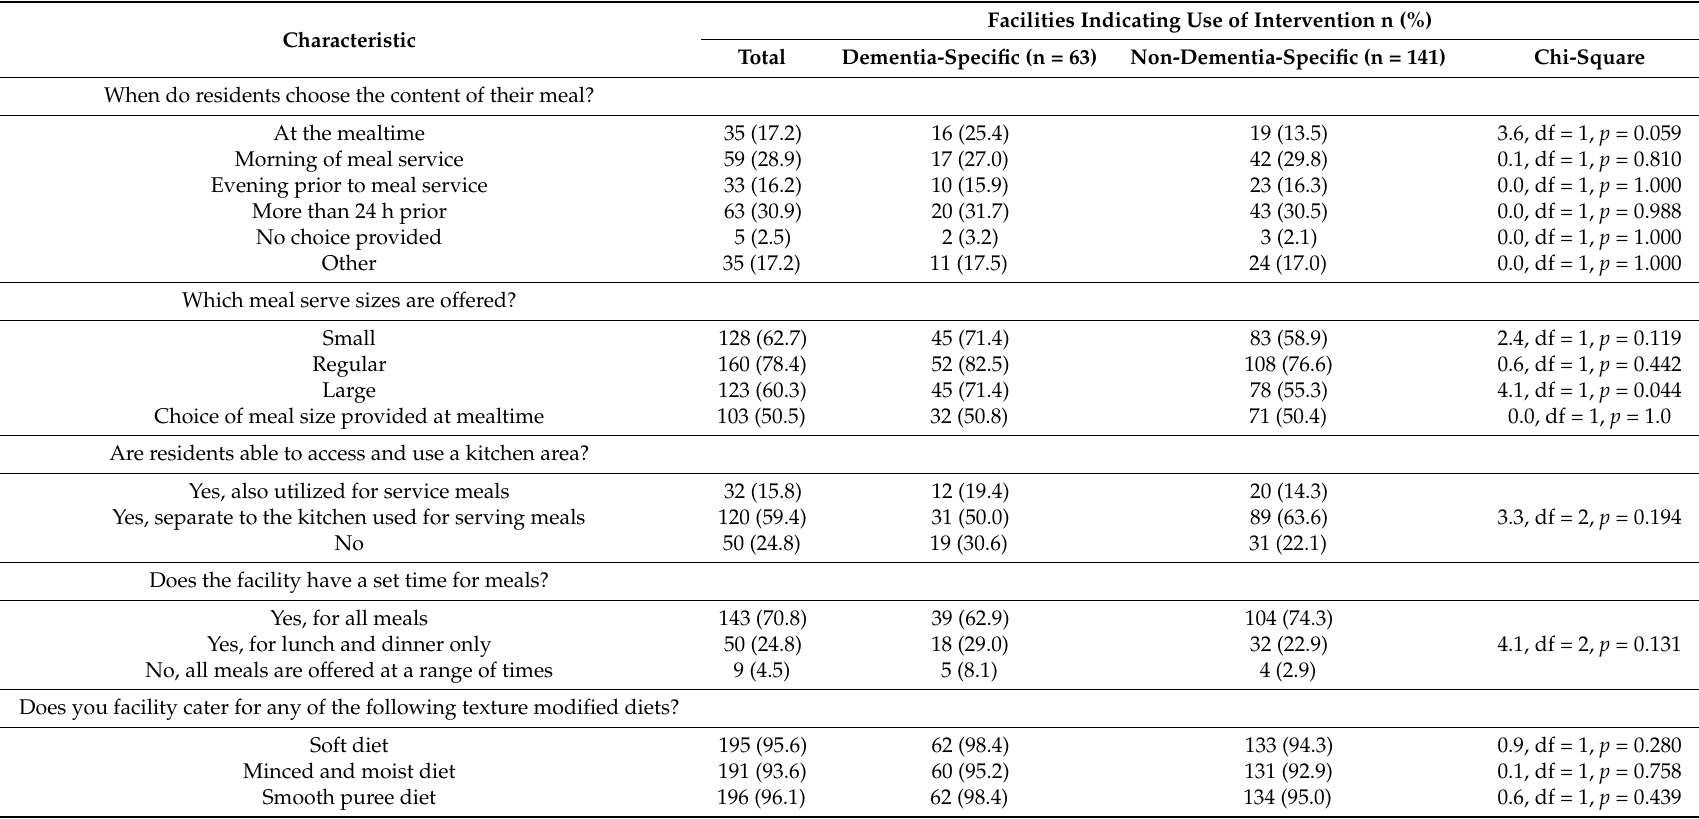
Table 4. Flexibility and extent of choice in food provision in dementia-specific and nonspecific